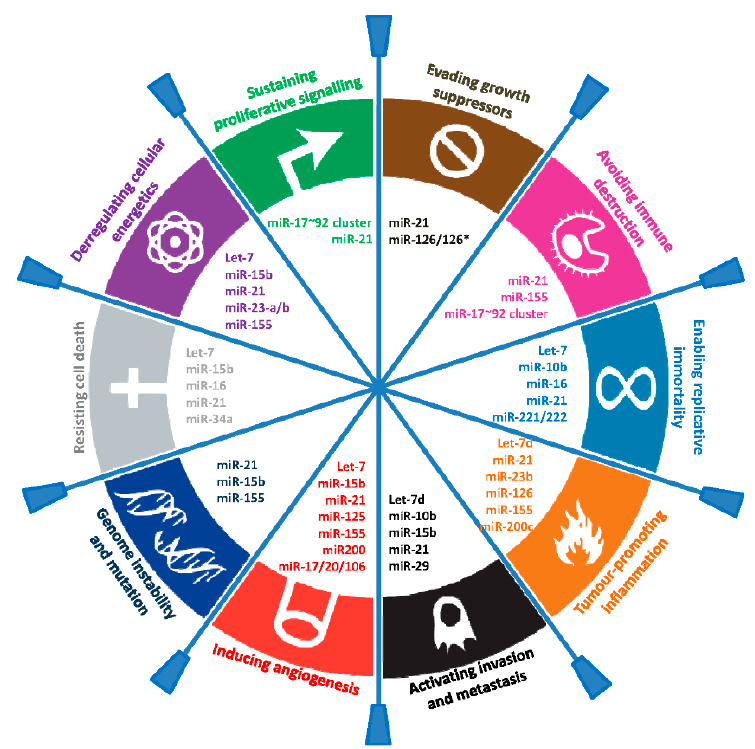
Figure 2. Selected circulating cell-free microRNAs (cfmiRNAs) and their functional role in the hallmarks of cancer.The figure lists some examples of biomarker cfmiRNAs (with a focus on the ones described in this review) that regulate genes involved in the different hallmarks of cancer as defined by Hanahan and Weinberg [18].